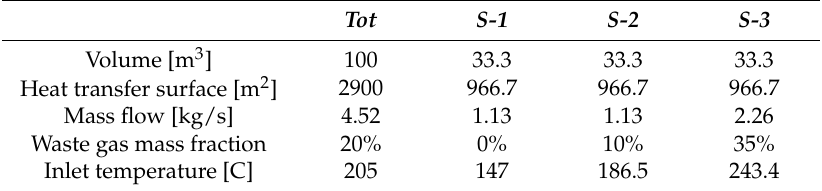
Table 3. Parameters values of the Cold RC with the Waste Gas Recirculation (WGR) system.